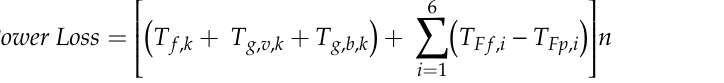
Figure 11. Power losses for DLC-coated gears, scenario 1. The use of WCC coating has a similar effect, as presented in Figure 12 for the same operating conditions of scenario 1. Since the surface properties of the two coatings differ as measured experimentally, a different effect on the power loss change was expected. However, it should be noted that the power loss was reduced in all coated gears. In order to further verify the effects of each